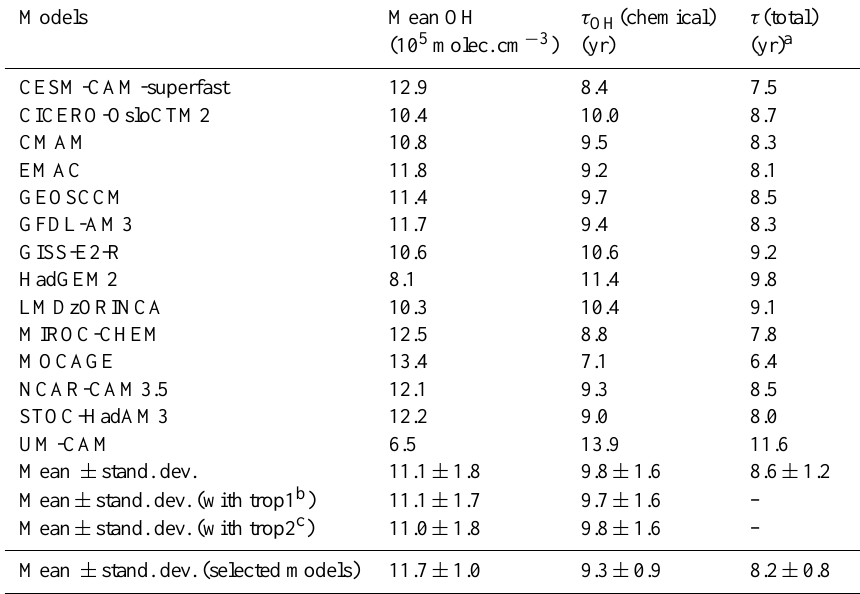
Table 1. Present day (2000) tropospheric mean (air mass weighted) OH concentration, tropospheric chemical methane lifetime ( τ OH ), and total methane lifetime ( τ ) for the 14 participating models. Multi-model means and standard deviations, as well as mean OH concentrations under different tropopause definitions, are also shown. If not indicated otherwise, we integrated the tropospheric OH loss from 200hPa to the surface. The last row shows the means and standard deviations using a subset of models, excluding HadGEM2 and UM-CAM. Models